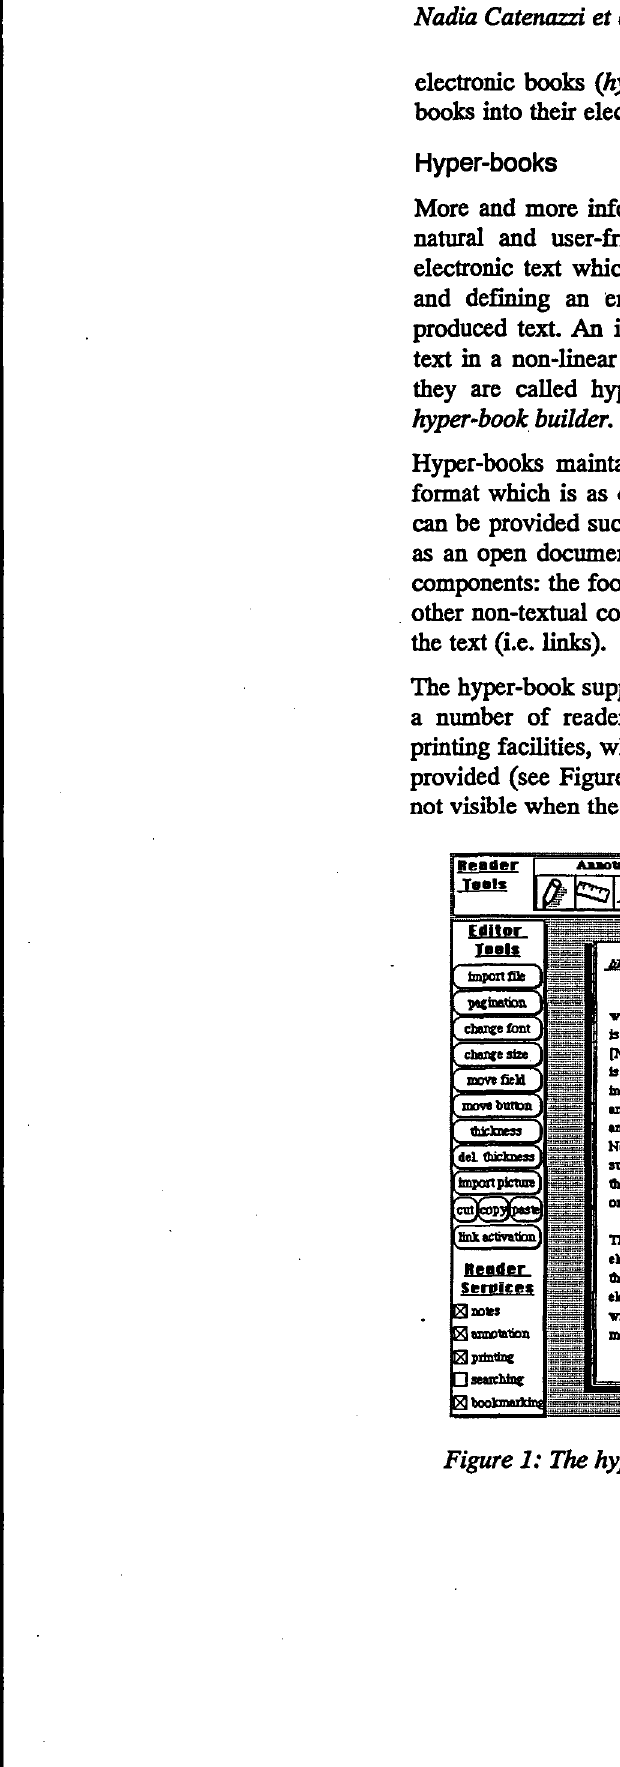
Figure 1: The hyper-book template: designer and reader